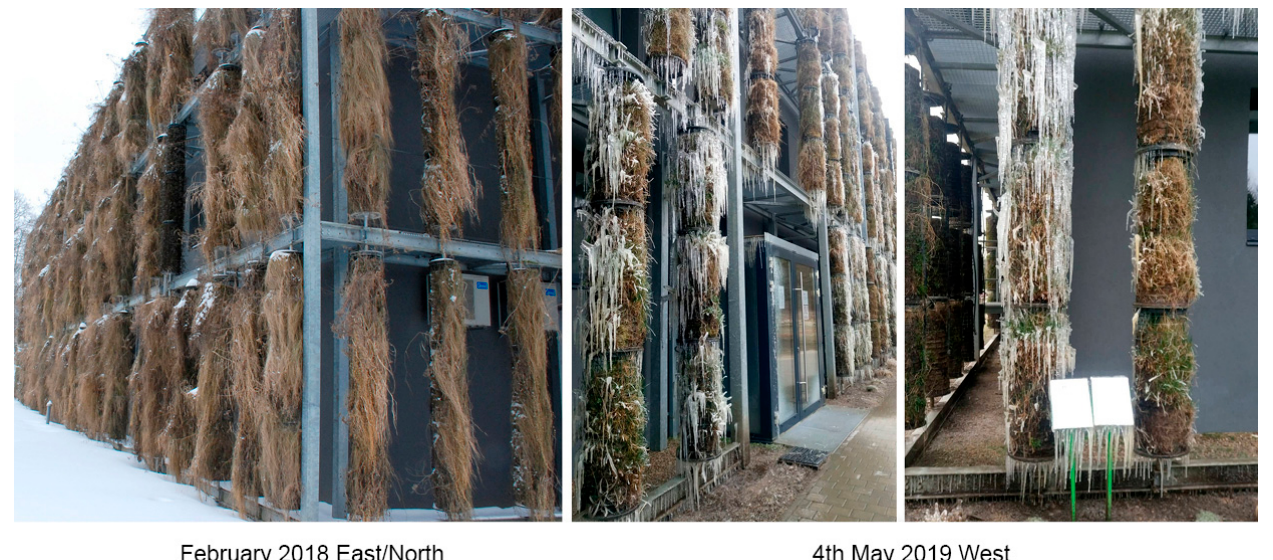
Figure 6 . Winter view of the green columns on the east/west exposition, February 2018; the damaging effect of a sudden frost in the green columns in the early spring season on the west exposition, 4th of May 2019. Table 6. Overview of severe meteorological incidents in the study years 2017–2021.